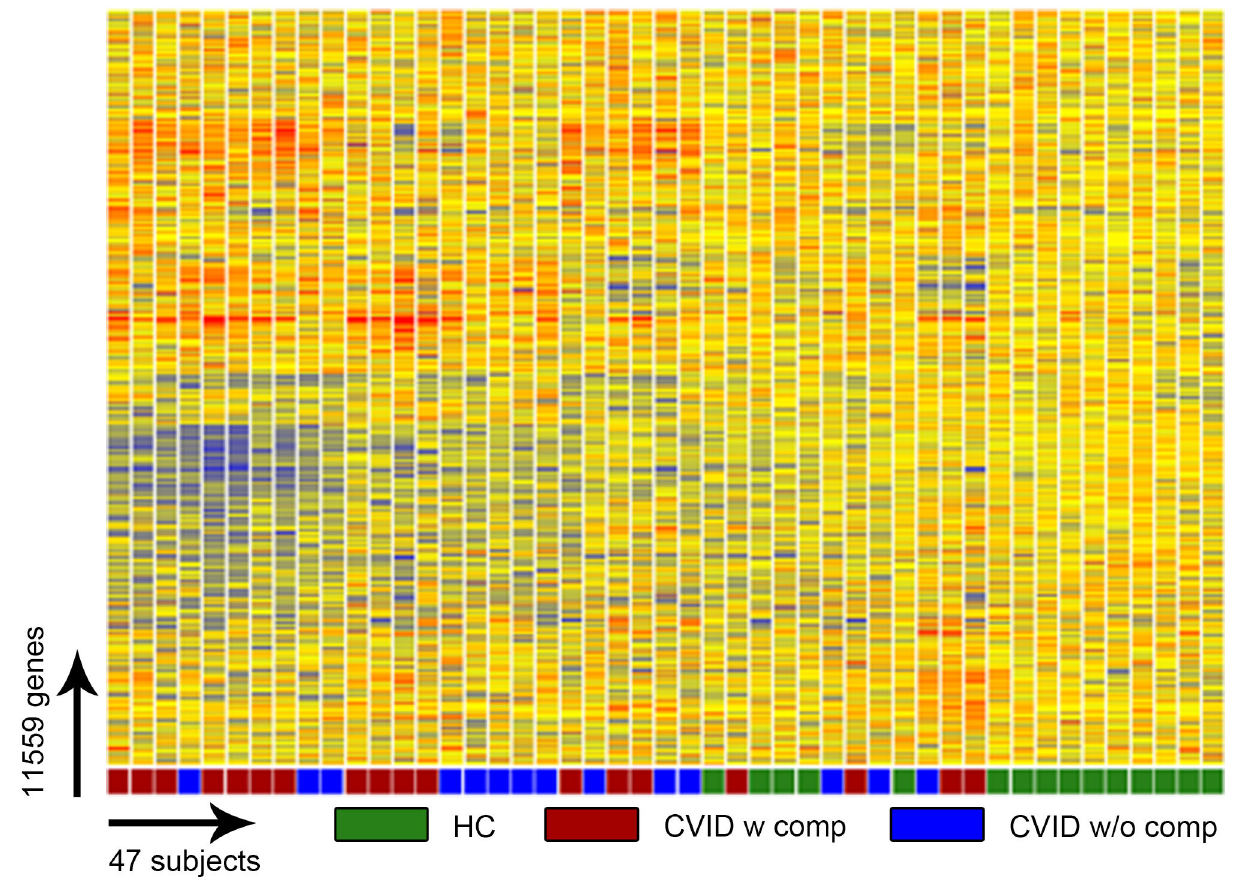
Figure 4. Gene expression analysis of CVID blood (test set) compared to healthy controls. Unsupervised clustering of 11,559 RNA transcripts in whole blood cells, selected by Present At least Once (PALO) differentiates CVID patients from healthy controls in the test